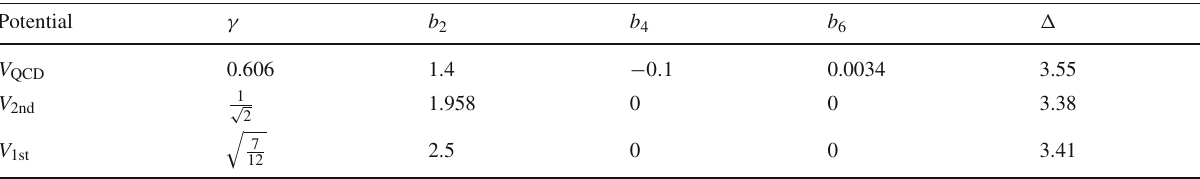
Table 1 The three scalar potential V QCD , V 2nd and V 1st